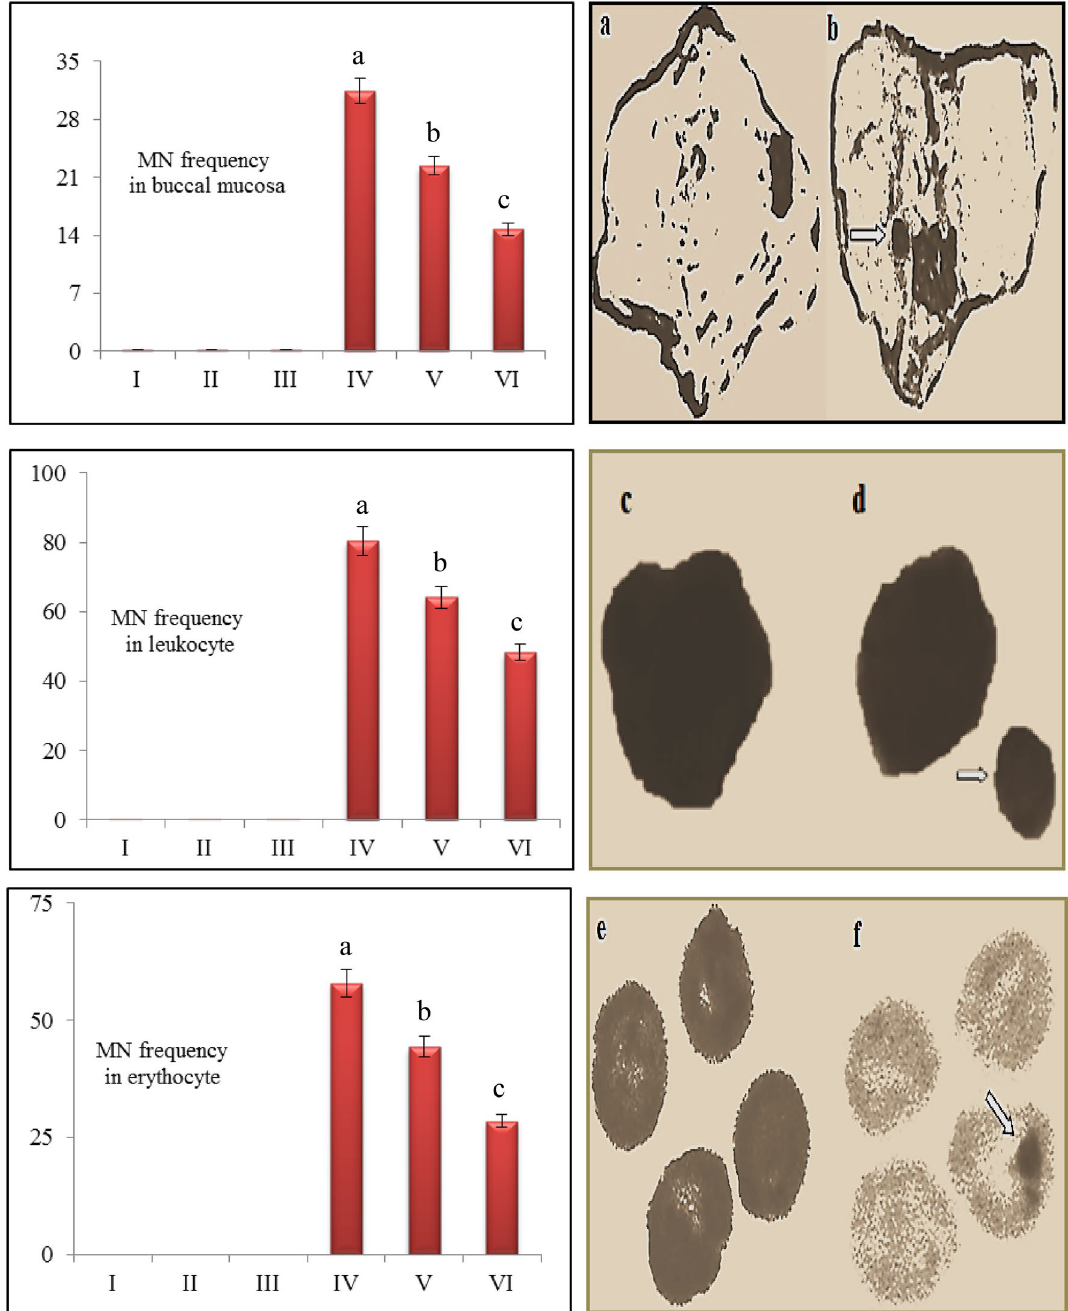
b.w AFB 2 , Group V: 10 mg/kg b.w resveratrol + 20 µg/kg b.w AFB 2 , Group VI: 20 mg/kg b.w resveratrol + 20 µg/ kg b.w AFB 2 . ( a ) normal nucleus in the buccal mucosa epithelium cell, ( b ) MN in the buccal mucosa cell, ( c ) normal nucleus in leukocyte cell, ( d ) MN in the leukocyte, ( e ) normal nucleus in erythrocyte cell, ( f ) MN formation in the erythrocyte. Each histogram is a decimal average. The vertical lines on the bars indicate the standard error. Different letters (a–d) indicated averages p < 0.05 is